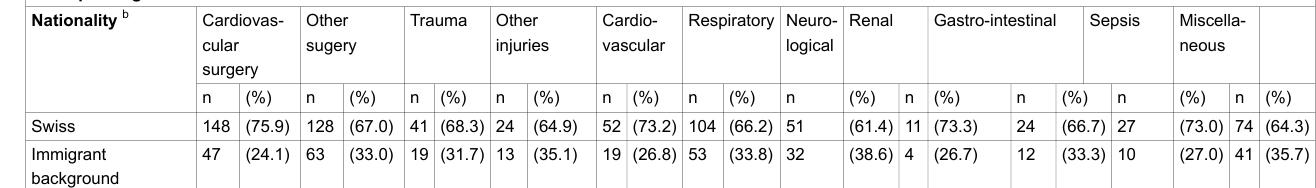
Table 2: Principal diagnosis, mode of admission, length of stay, need of ventilation, length of ventilation by nationality. Principal diagnosis a Cardiovas-